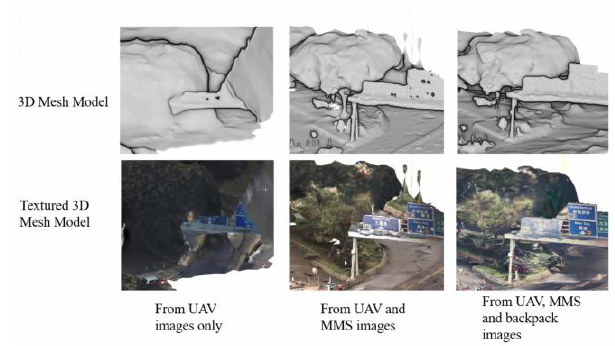
Figure 14. Comparison of 3D models of traffic